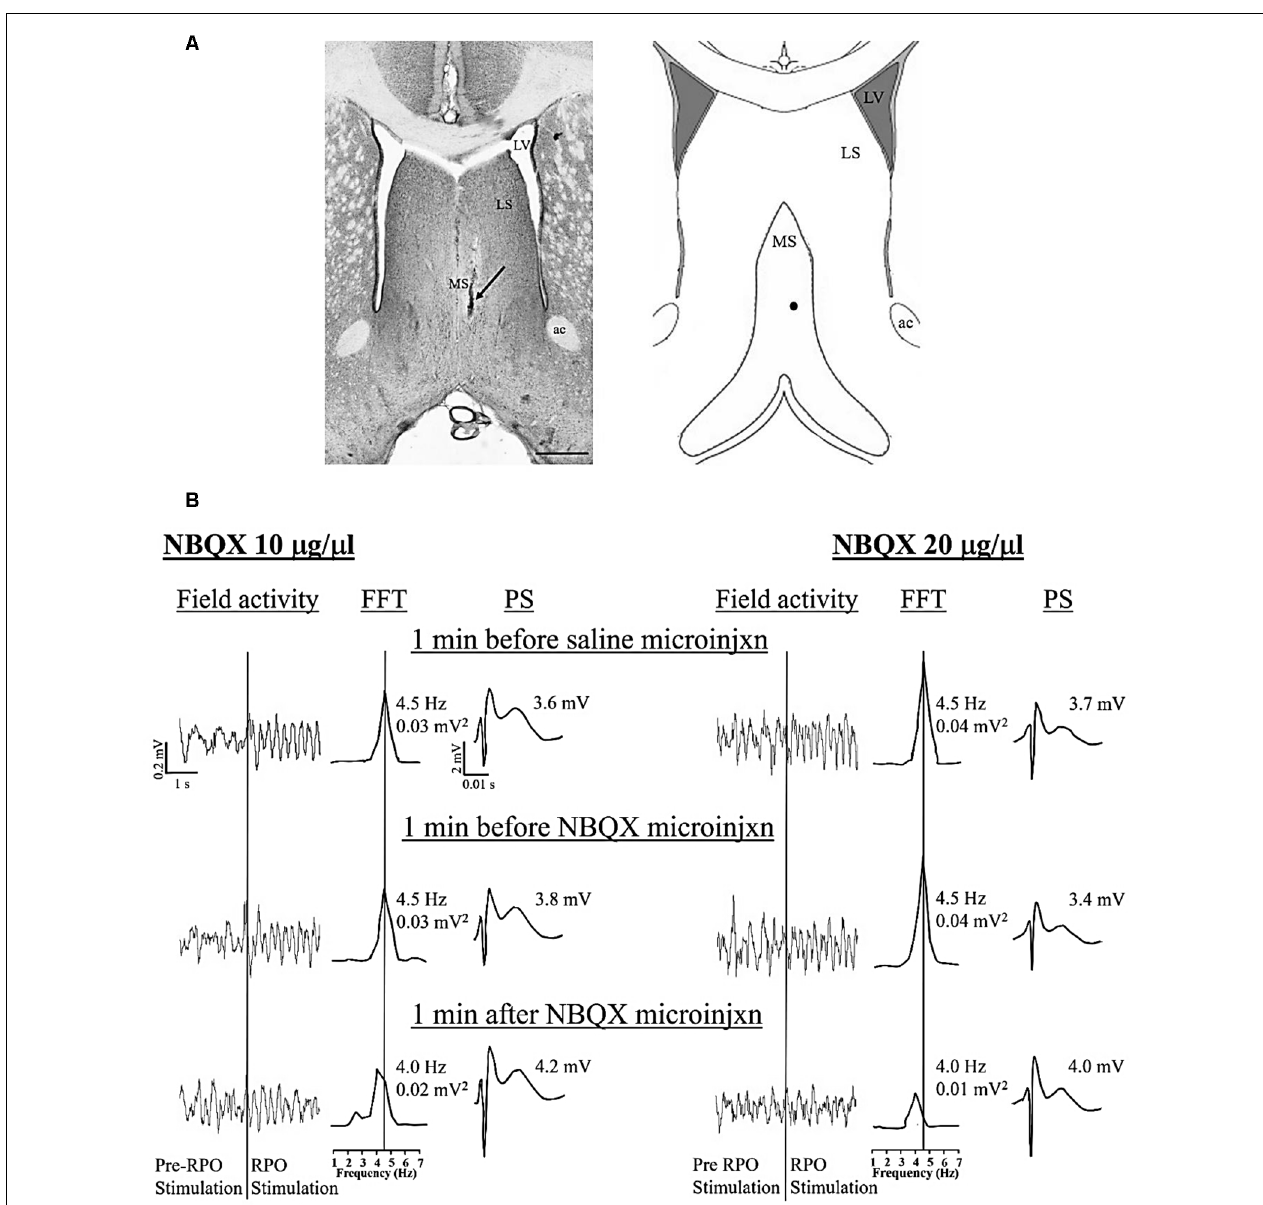
FIGURE 1 | Dose-dependent effect of intraseptal microinjection of glutamate antagonist on reticularis pontis oralis (RPO) stimulation-induced hippocampal theta wave activity. (A) Digital representative image (left) of a microinjection site in the medial septum (MS) and the corresponding diagrammatic representation (right). The arrow (left) and the black dot (right) points to the Alcian blue dye, indicating the site of the microinjection. The scale bar on the digital micrograph represents 1.0 mm. The diagram on right is adapted from Paxinos and Watson (2014). (B) Representative electrophysiological responses recorded in the pyramidal cell layer of the hippocampus. The electrophysiological responses were taken from animals that received microinjection of 2,3-Dioxo-6-nitro-1,2,3,4-tetrahydrobenzo[f]quinoxaline-7-sulfonamide (NBQX, an AMPAR antagonist; 0.5 µ l) at a dose of 10 µ g/ µ l (left) or 20 µ g/ µ l (right). The effect of each dose is illustrated on RPO stimulation-induced change in both hippocampal field activity (left) and the CA1 population spike (PS; right). The middle traces are fast Fourier transform (FFT; frequency resolution of 0.5 Hz) of the 2 s of RPO stimulation-induced field activity in the traces on the left of the FFT. RPO was stimulated every 10 s (0.1 Hz) for 2.56 s using a 100 Hz train (pulse width of 0.01 ms). FFT theta peak power, expressed as mV 2 and normalized to the standard calibration unit, and the FFT theta peak frequency are indicated beside the FFT. The lines from the FFT theta trace at the top to the scale underneath indicate the FFT peak frequency corresponding to the FFT theta peak power. The PS was evoked on CA3 stimulation (0.1 Hz, 0.01 s pulse duration). The stimulation intensity was adjusted to evoke PS of about 75% of the maximal amplitude under conditions of large irregular field. The CA3 stimulation was timed to occur 10 ms after RPO stimulation. The amplitude of PS shown on the right of each PS trace reflects the average PS in 1 min block. During the experiment, vehicle (saline, 0.5 µ l) was microinjected 10 min after the onset of RPO stimulation followed 10 min later by the microinjection of one of the two doses of NBQX. The electrophysiological responses illustrated in (B) were selected at three different time points as shown in the figure. Notice the reduction in both FFT theta peak power and frequency on microinjection of NBQX 20 µ g/ µ l. Abbreviations: ac, anterior commissure; LS, lateral septum; LV, lateral ventricle; MS, medial septum; microinjxn, microinjection.